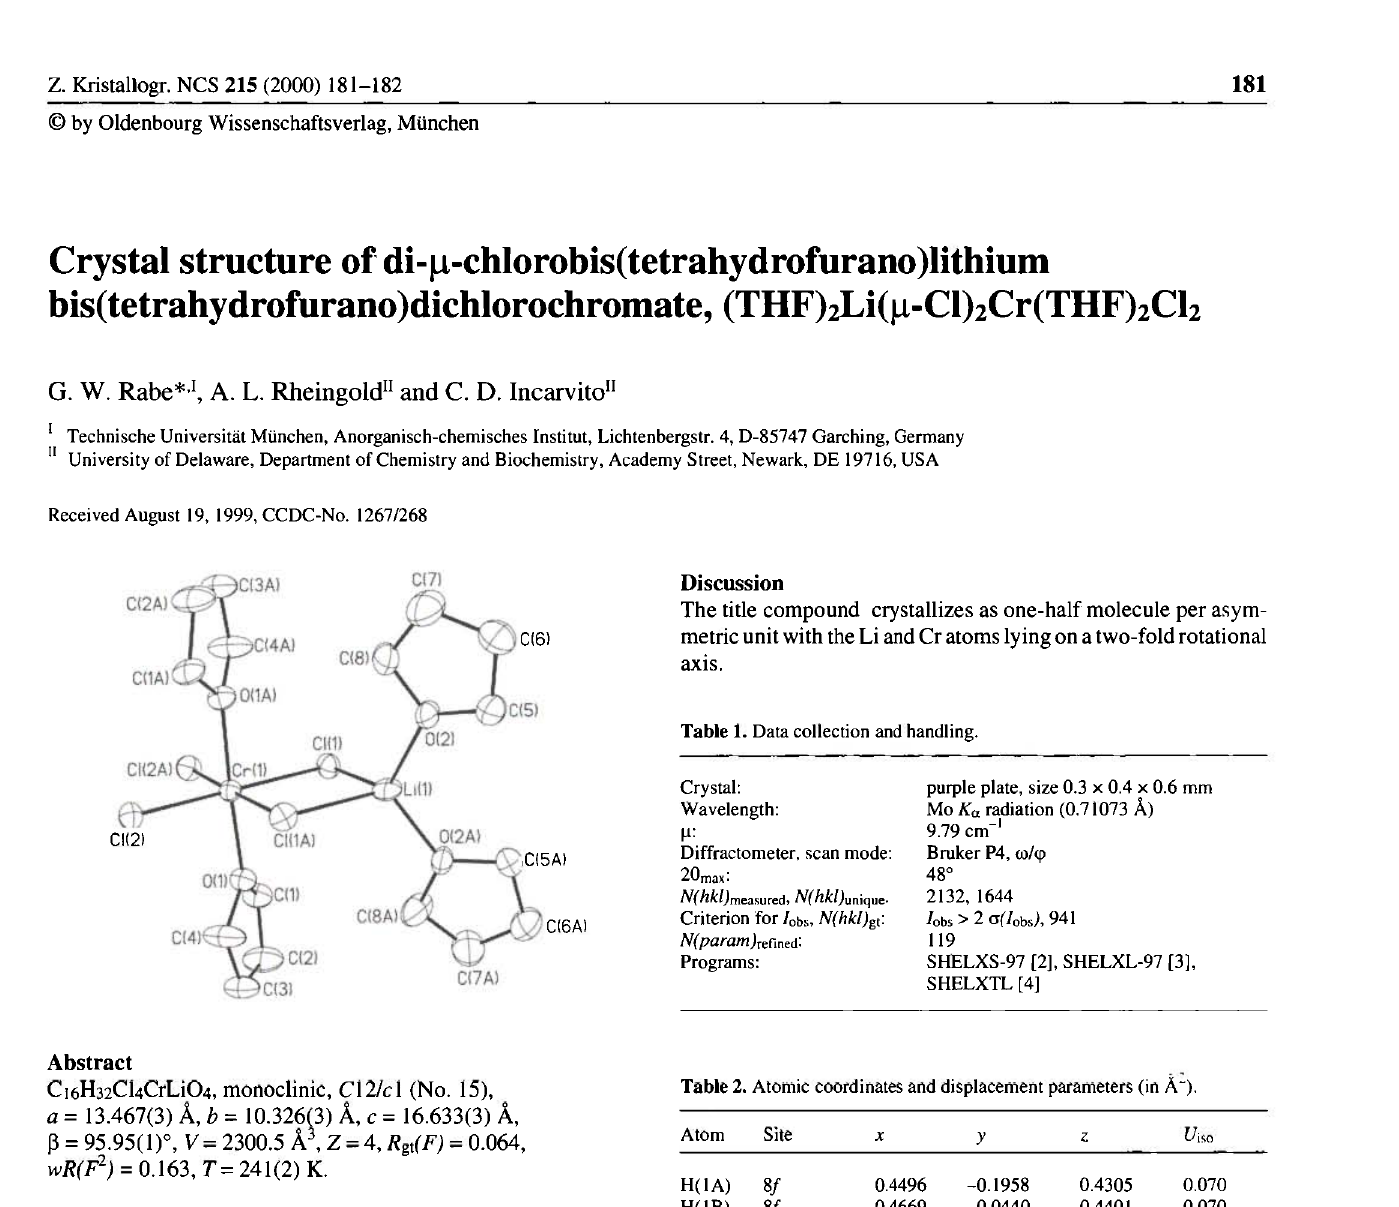
Table 2. Atomic coordinates and displacement parameters (in A").